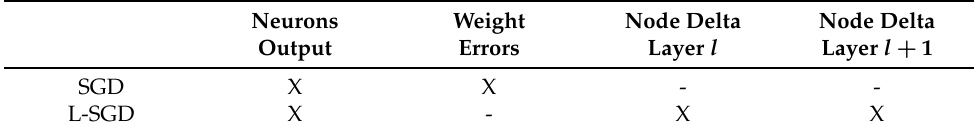
Table 1. SGD vs. L-SGD: main memory